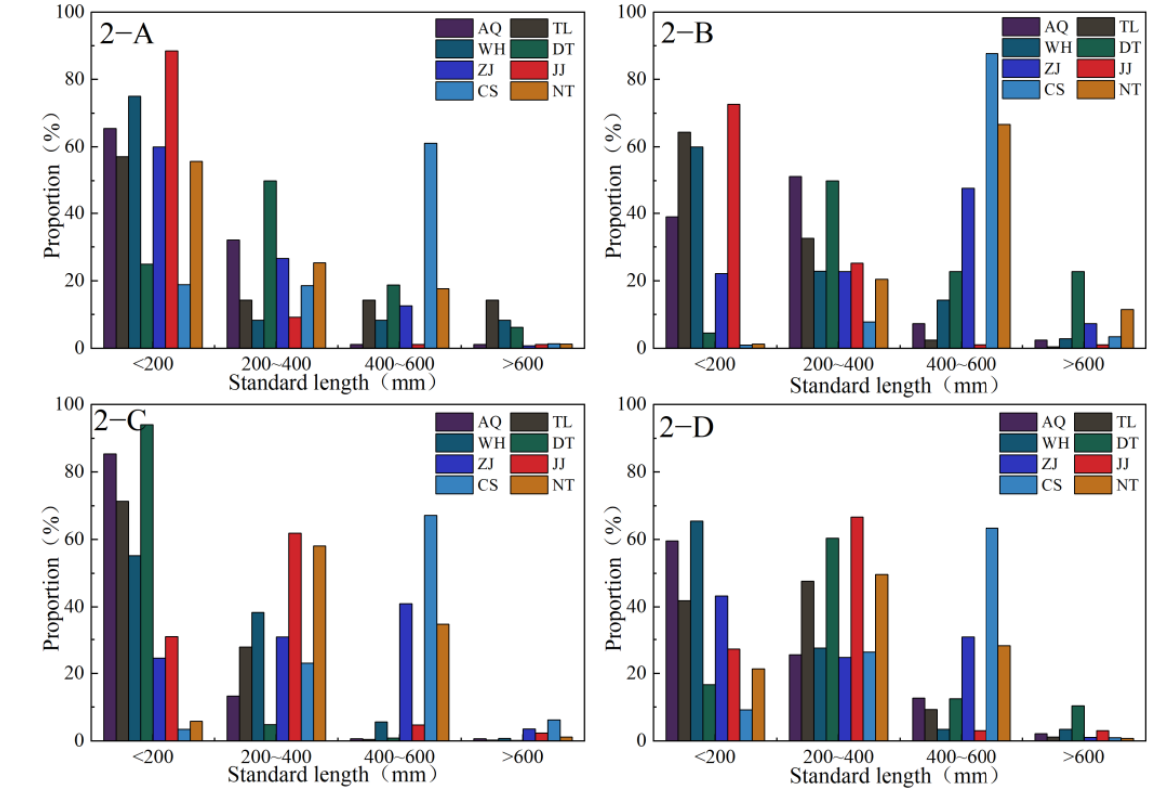
Figure 2. Seasonal distribution patterns of Silver Carp in the lower Yangtze River. ( 2 − A )The proportion of Silver Carp in different SL groups in spring; ( 2 − B ) the proportion of Silver Carp in different SL groups in summer; ( 2 − C ) the proportion of Silver Carp in different SL groups in autumn; ( 2 − D ) the proportion of Silver Carp in different SL groups in winter .